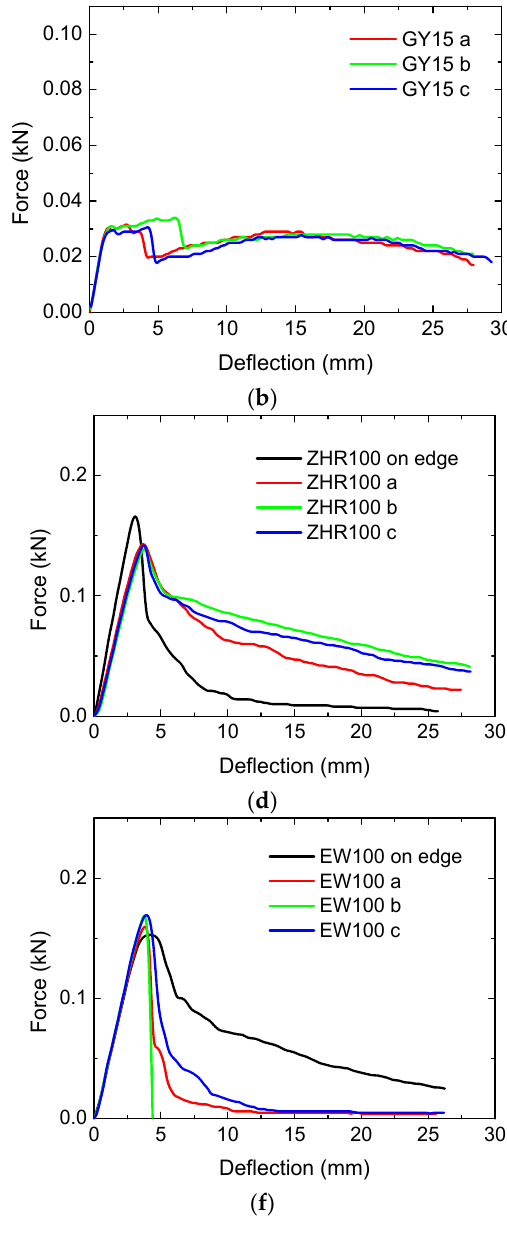
Figure 1. Three-point bending tests of samples with different infill patterns: ( a ) LN100; ( b ) GY15; ( c ) OC15; ( d ) ZHR100 including one specimen printed on the long edge; ( e ) LP100 including one specimen printed on the long edge; and ( f ) EW100 including one specimen printed on the long edge. Y-axis scales differ.